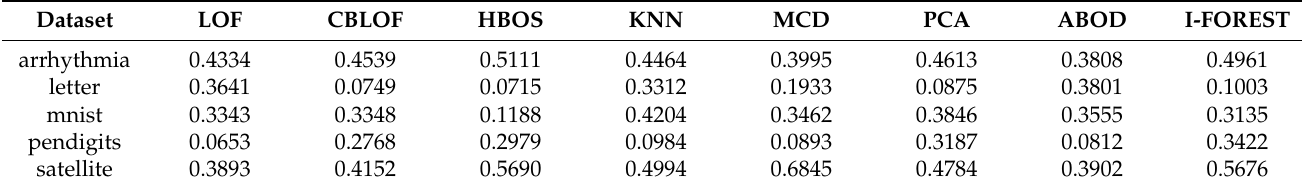
Table 3. Overview of precision using the studied algorithms in different datasets.